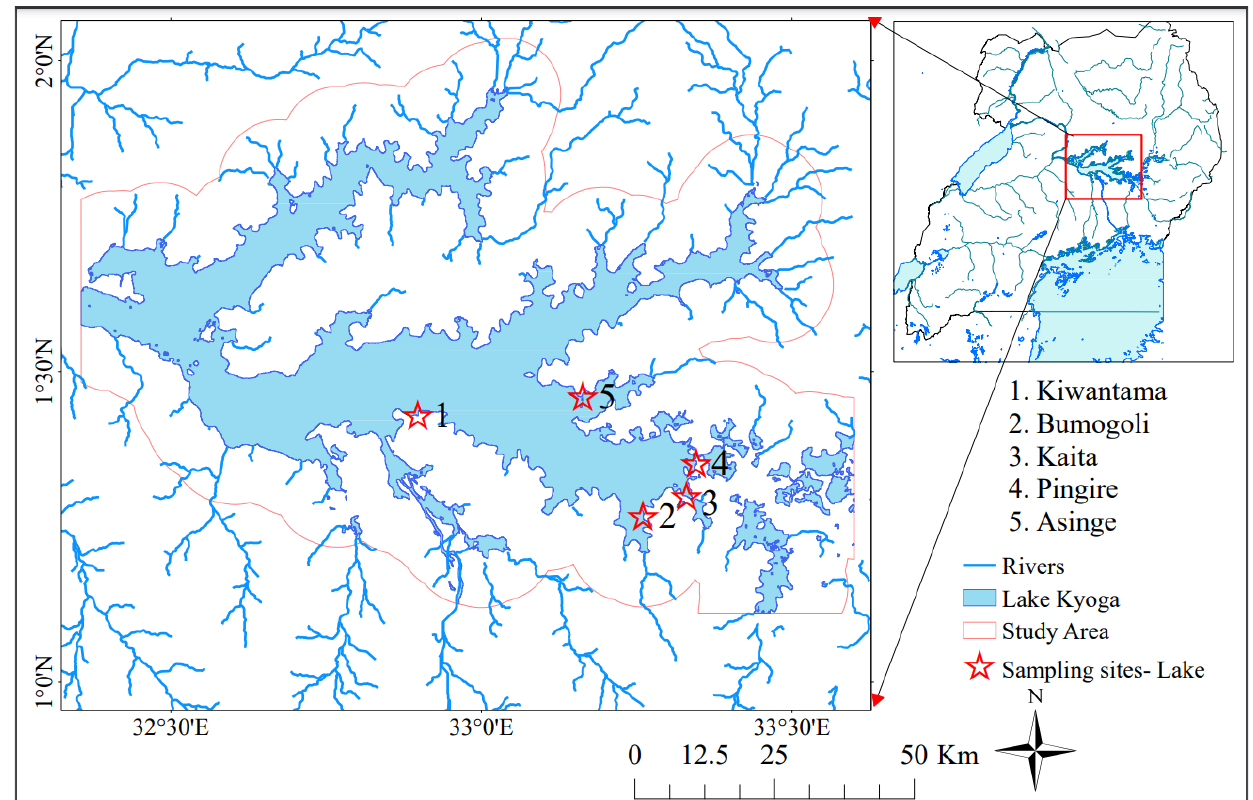
Figure 1. Sampling sites within the study area.